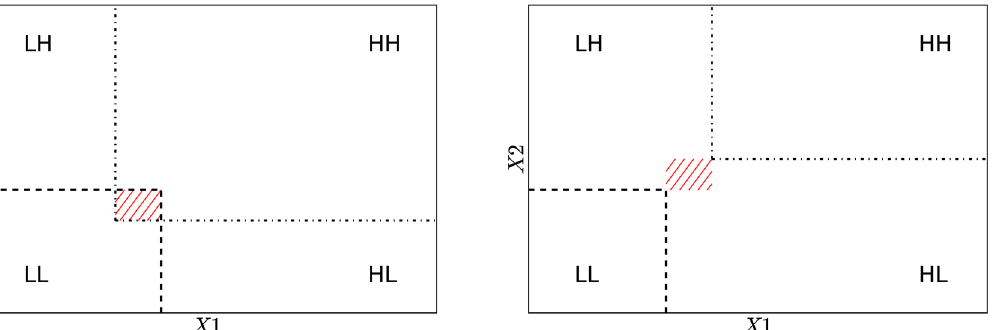
Fig 3. Definition of the binary regions. At each iteration step, the most common situation is that the delimiters do not determine a perfect partition of the variable space. We show two typical cases for the bivariate ( X 1, X 2) case with delimiters overlapping (left panel) and non-overlapping (right panel). Delimiters are shown as dashed lines ( r . L , r L . ) and as dot-dashed lines ( r . H , r H . ). Left: the data points in the middle red area may belong either to R are considered in the computation of both μ LL and μ HH . Right: with non-overlapping delimiters, we can still fi gure out an overlapping area between regions R and R by extending the delimiters (middle red area), hence data points in this area are considered in the computation of both μ LH and μ HL LH HL